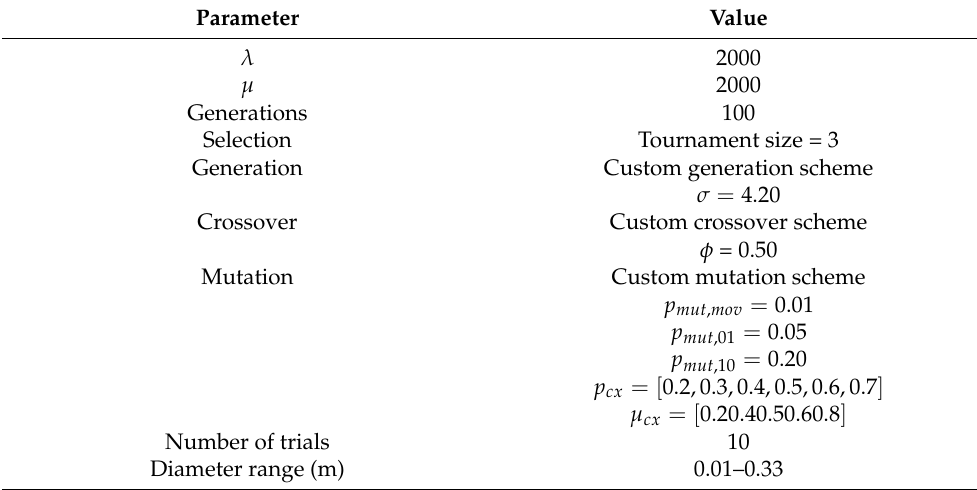
Table 2. Parameters of the Genetic